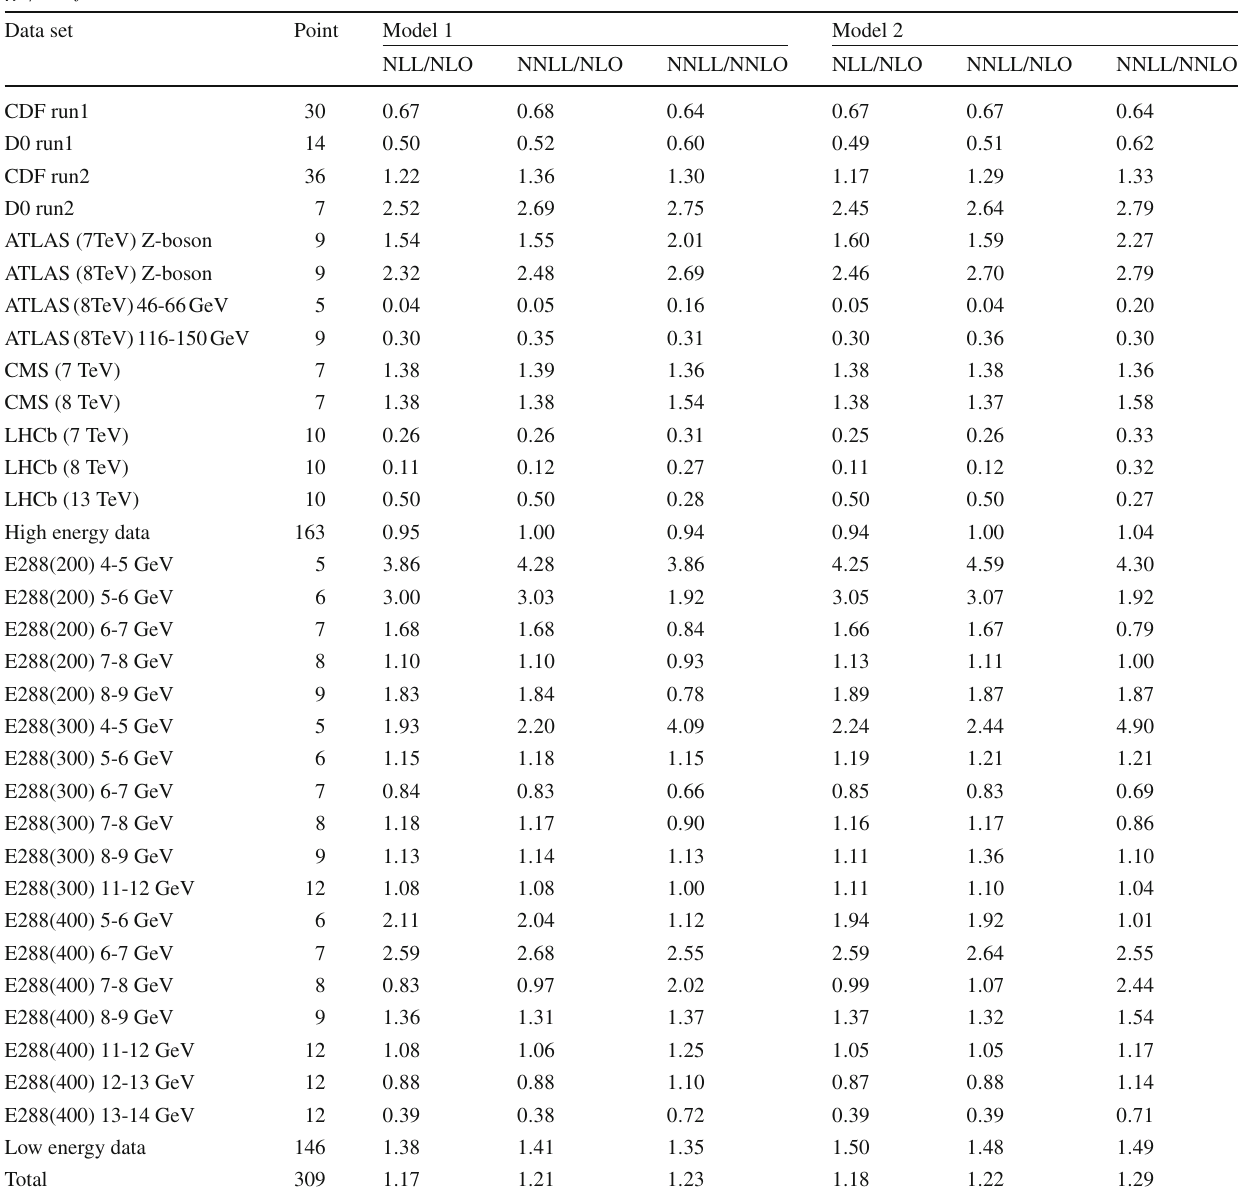
Table 15 The values of χ 2 / points for individual data sets. The boxes indicate the values of partial χ 2 which are responsible for the increment of χ 2 / d . o . f . from NLL/NLO to NNLL/NNLO Data